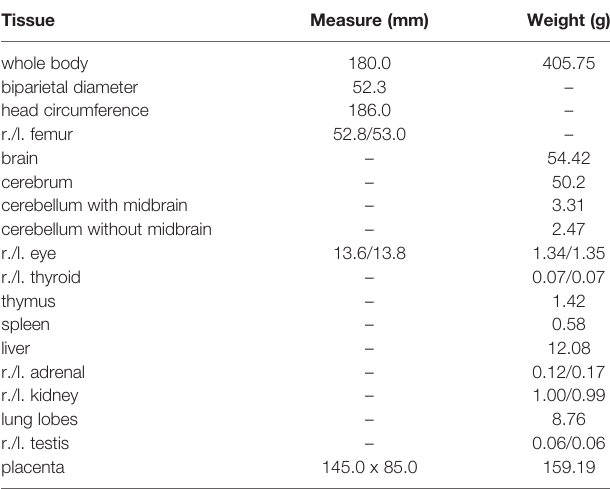
TABLE 3 | 049-101 fetal and placental measurements (~155 days gestation, 122 days post challenge).